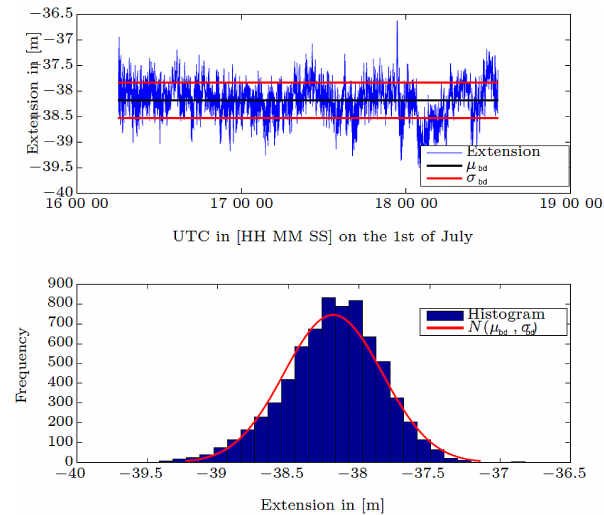
Figure 7. Top panel: this graph shows the dynamics of buoy 18 on the 1 July 2011 during a period of zero net movement near the maximum ebb current. The centimetre-accurate GPS position esti- mates are projected onto the dominant current direction and plotted against time. The mean and standard deviation from the mean have been determined ( µ = − 38.2m and σ =0.35m). The graph at the bottom shows the histogram of the extension and a best-fitting nor- mal